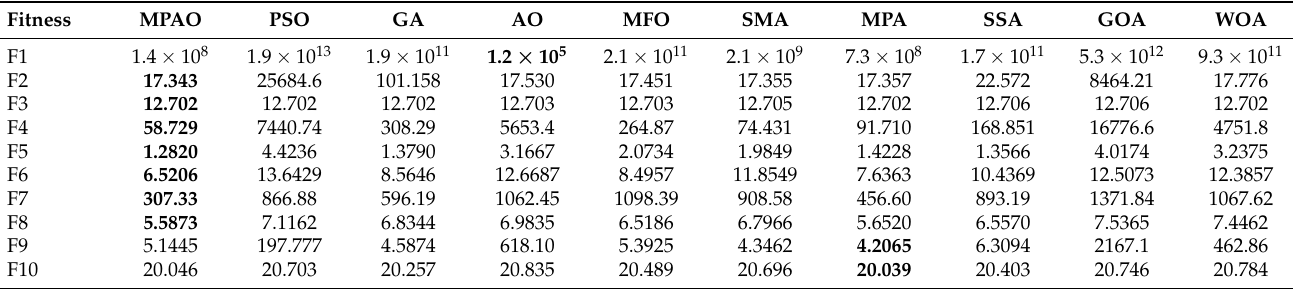
Table 5. Maximum values of the fitness function.